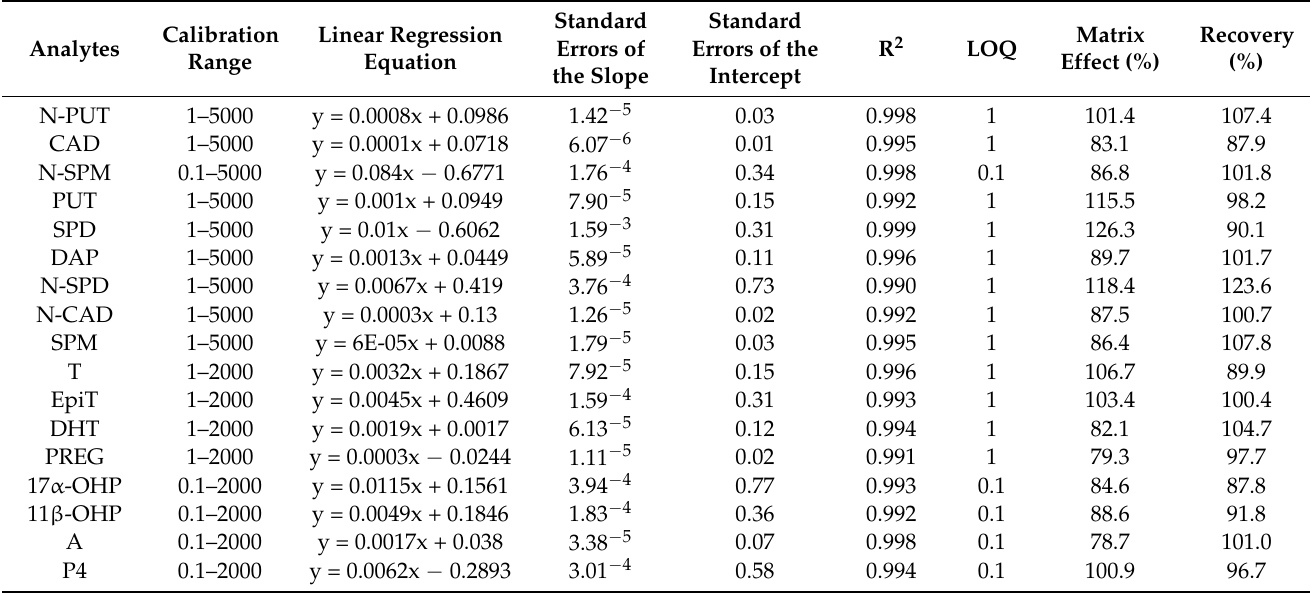
Table 1. Calibration range, linear regression equation, limit of quantification (LOQ), matrix effect, and recovery of polyamines and